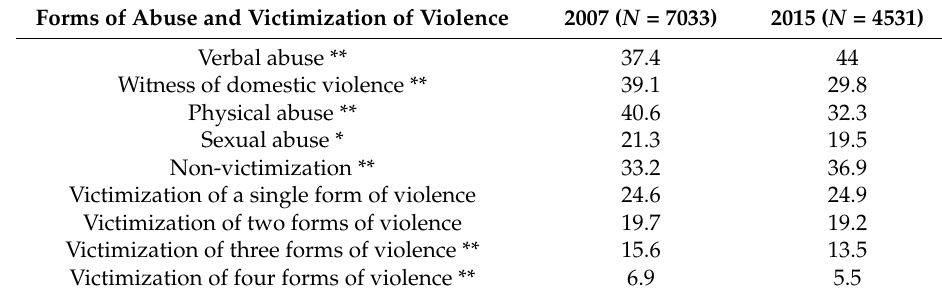
Table 1. Lifetime prevalence of victimization of each and all four forms of violence among Norwegian youth (2007 and 2015); results are presented in